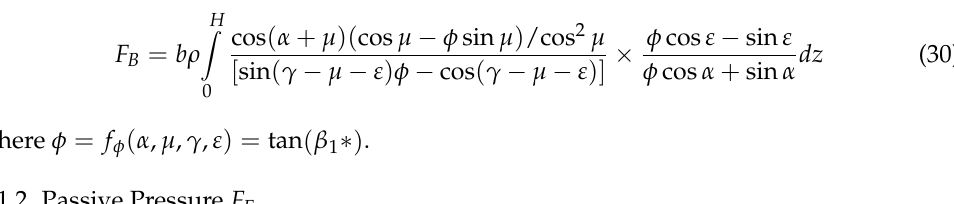
Figure 13 is a schematic diagram of the force of the unit body under passive pressure.